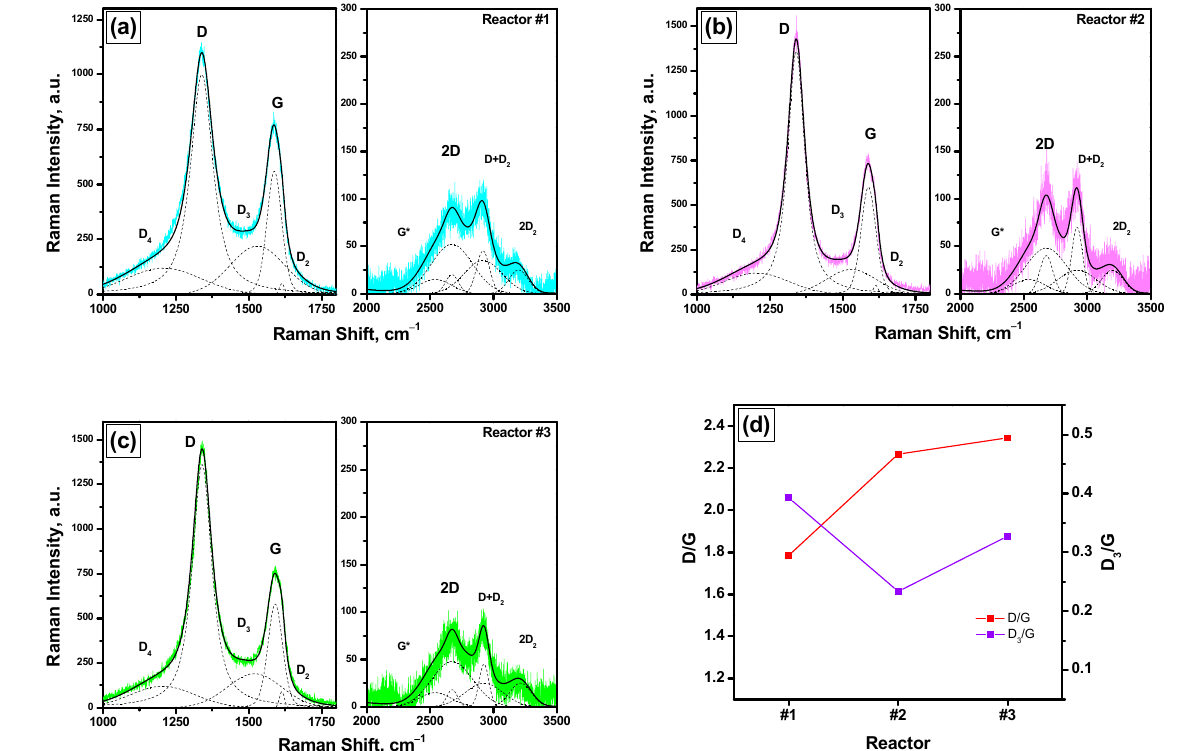
Figure 7. Raman spectra of the carbon nanostructures produced in different reactors: ( a ) reactor #1; ( b ) reactor #2; ( c ) reactor #3. Comparison of the D/G and D 3 /G ratios for the studied samples ( d ).